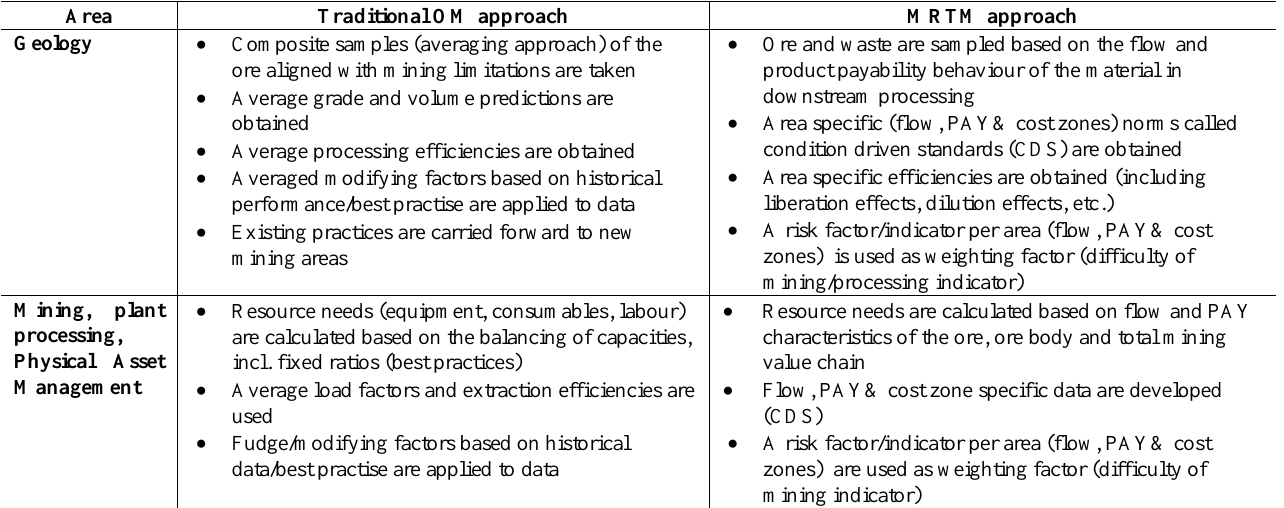
Table 3: Comparison between how data is generated and used within traditional OM and MRTM approaches